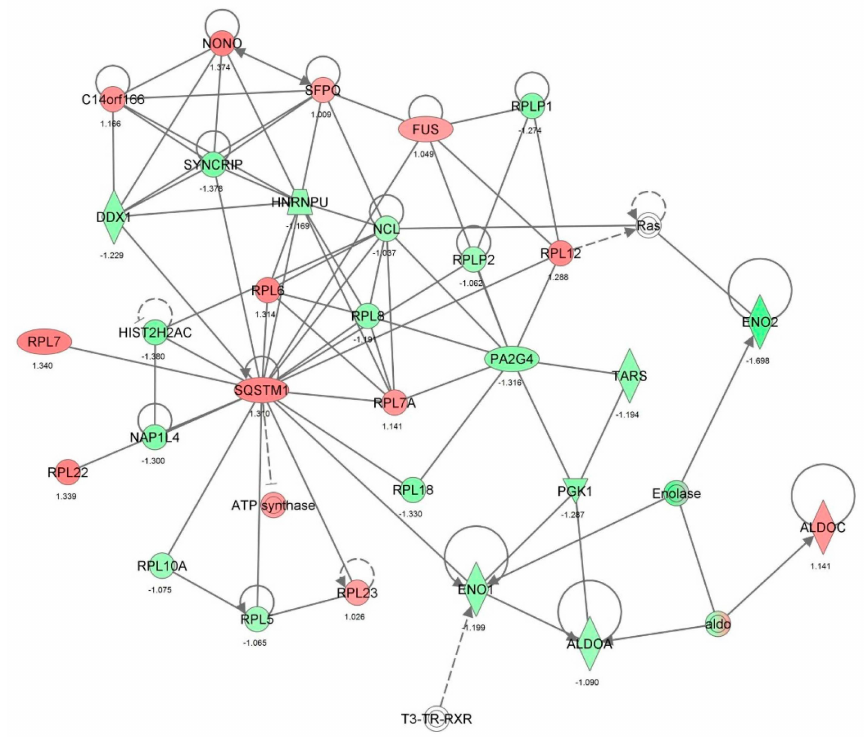
Figure 3. Vancomycin regulated RNA post-transcriptional modification, carbohydrate metabolism, and small molecule biochemistry. Red indicates an up-regulation; green indicates a down-regulation. The intensity of green and red colors indicates the degree of down- or up-regulation. Solid arrow indicates direct interaction and dashed arrow indicates indirect